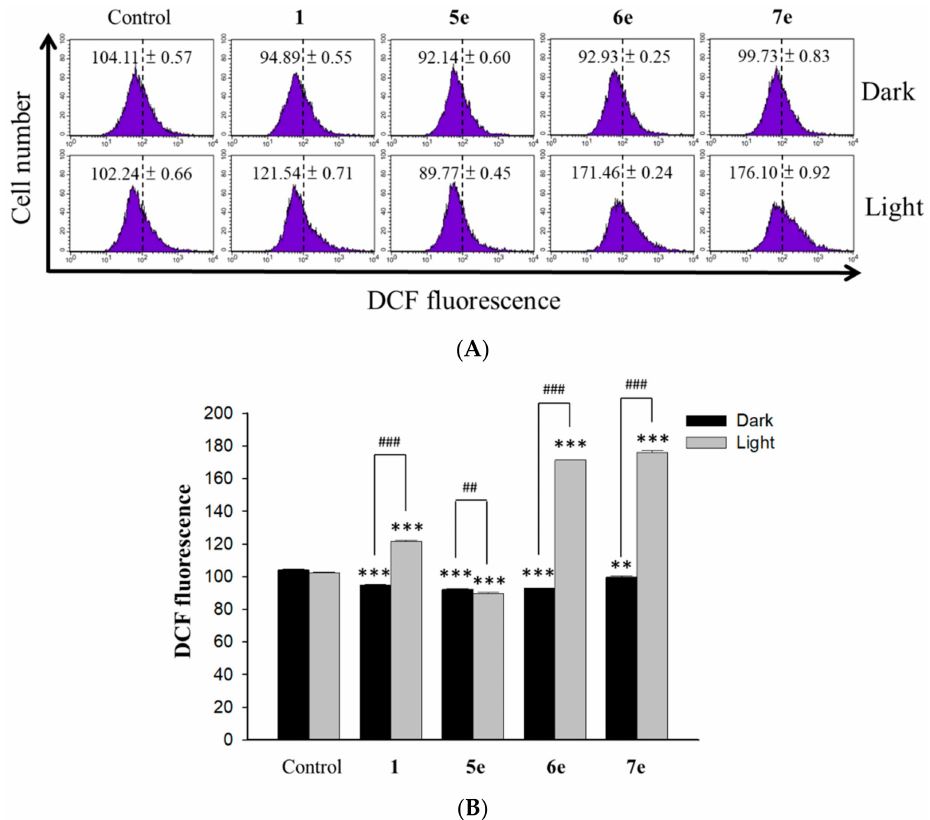
Figure 8. ROS generation in HepG2 cells treated with berberine ( 1 ), 5e , 6e , and 7e after irradiation. ( A ) The e ff ects of HepG2 cells treated with berberine ( 1 ), 5e , 6e , and 7e at 0.5 µ M concentration for 2 h after irradiation (420 nm, 10 min) for 24 h on percentage distribution of ROS generation by DCFH-DA staining. ( B ) Average intensity of DCFH-DA fluorescence in HepG2 cells treated with berberine ( 1 ) and its derivatives 5e , 6e, and 7e at 0.5 µ M concentration. The results are presented as mean ± SD. *** p < 0.001 compared with control, ## p < 0.01 and ### p < 0.001 compared with the dark